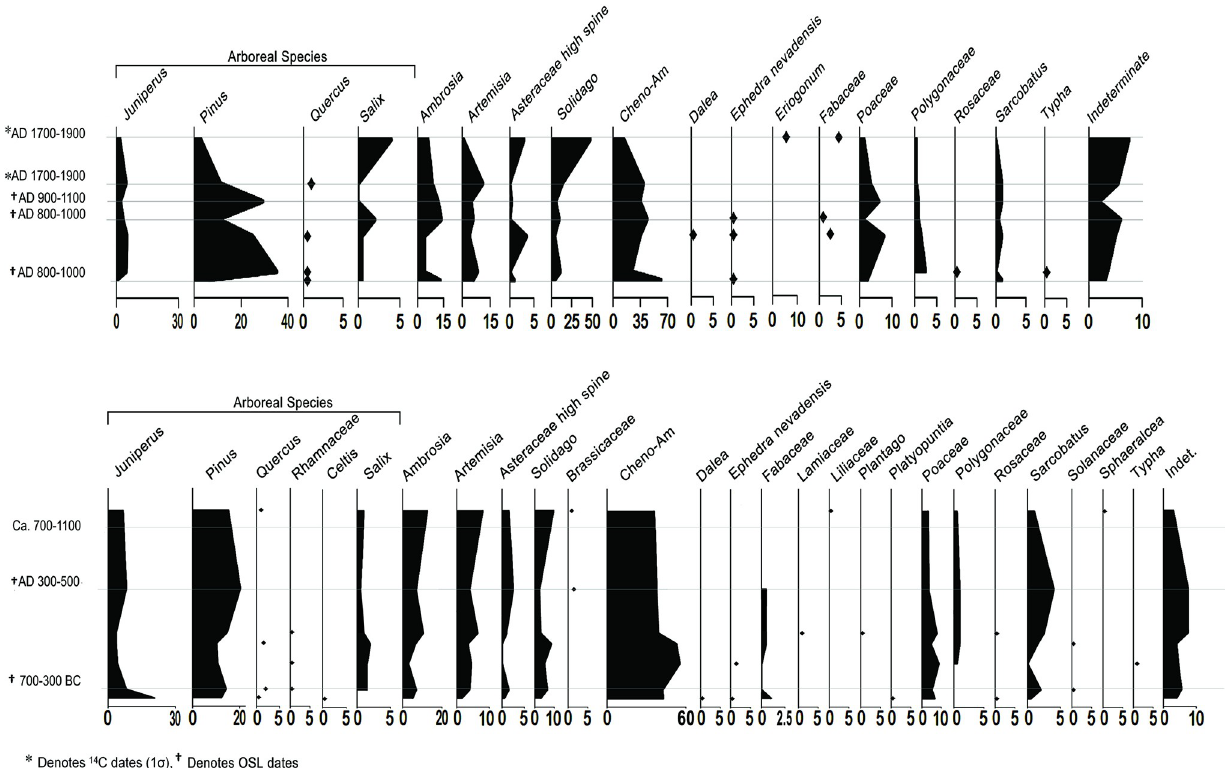
Fig 5. Pollen profiles. From Operations C-1/3 (top) and C-2 (bottom) (drawn by Cory Perfetta and David Lentz).